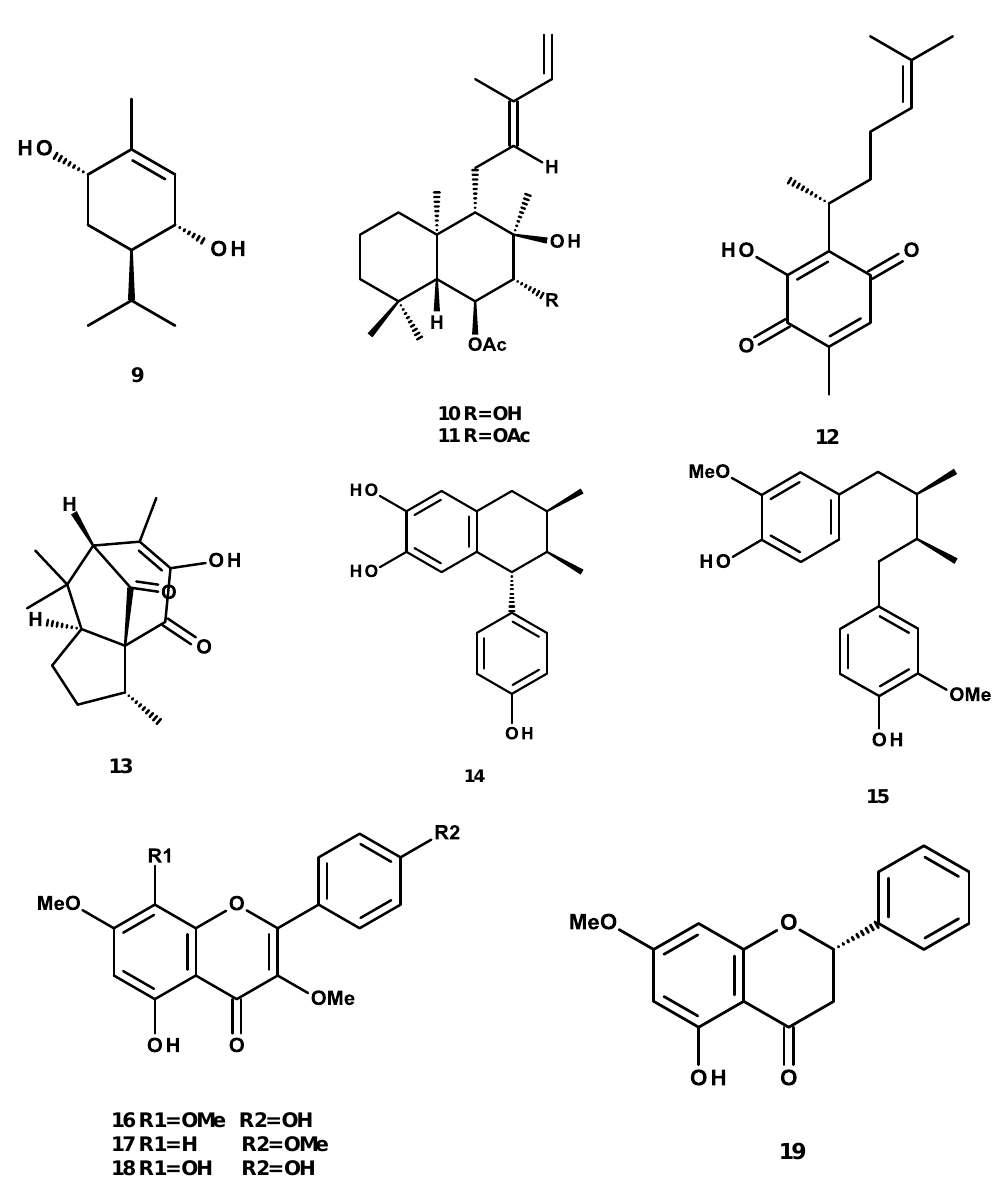
Figure 1. Chemical structures of studied compounds.